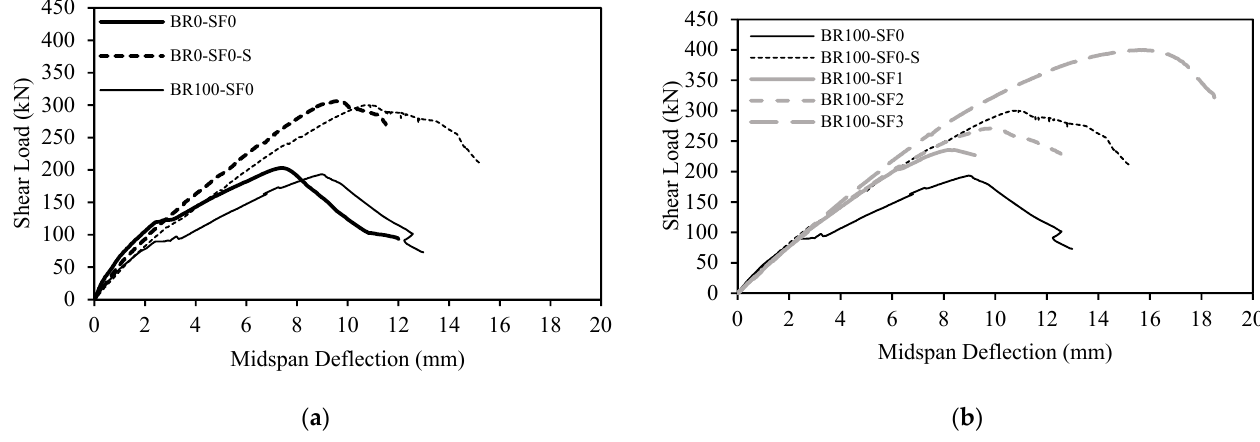
Figure 4. Shear load–deflection response: ( a ) beams without steel fibers; ( b ) RCA-based beams with and without steel fibers. Table 5. Summary of test results.